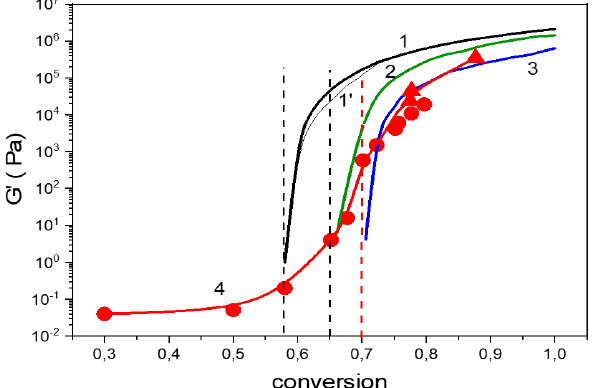
Figure 7. Evolution of the storage modulus as a function of conversion in the F4D2000–PPO3BMI system. T = 70 °C, theoretical curves (1–3): 1: ideal random system-affine network; 1’: gradual transition from the phantom to the affine network; 2: α intra = 0.06; 3: α intra = 0.11; curve 4: experimental data; ● network formation in between plates of rheometer; ▲ network formed in the mold. Dash lines: critical conversions of the ideal system and including the corresponding cyclization.